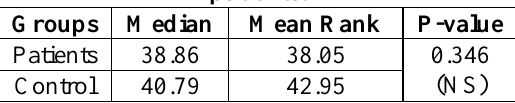
Table 6: The median and mean rank difference of serum Anti-SSB (ng/ml) in SSc patients.